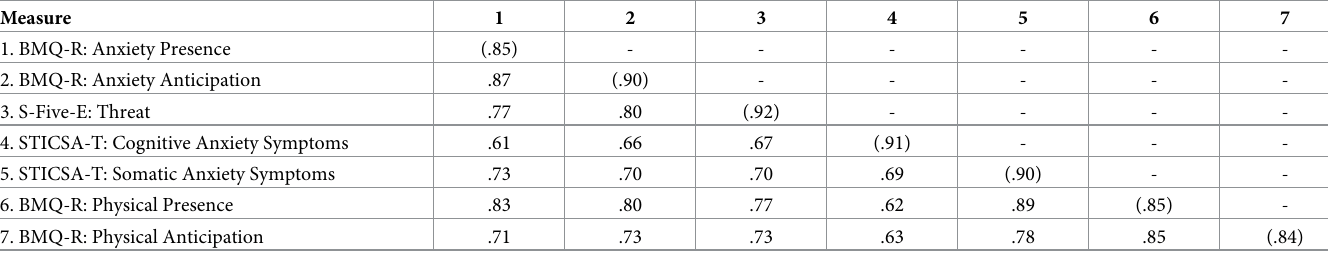
Table 6. Latent intercorrelations for misophonic anxiety and physical reactions with convergent measures. Measure